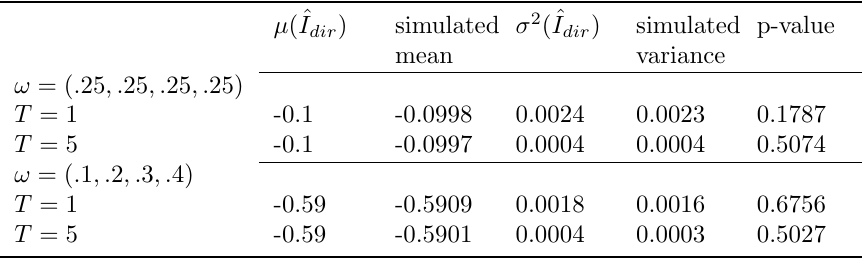
Comparison between simulated and theoretical mean and variance, and Shapiro-Wilk test’s p-value for Normality.